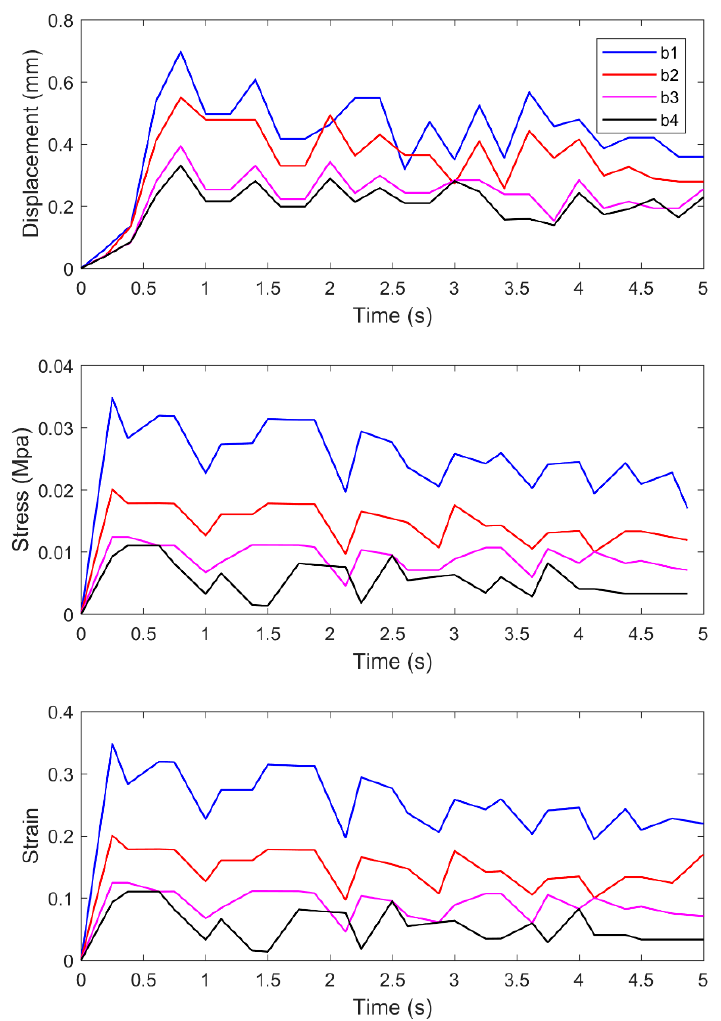
Figure 12. Curves of displacement, stress, and strain of transverse monitoring points with time.